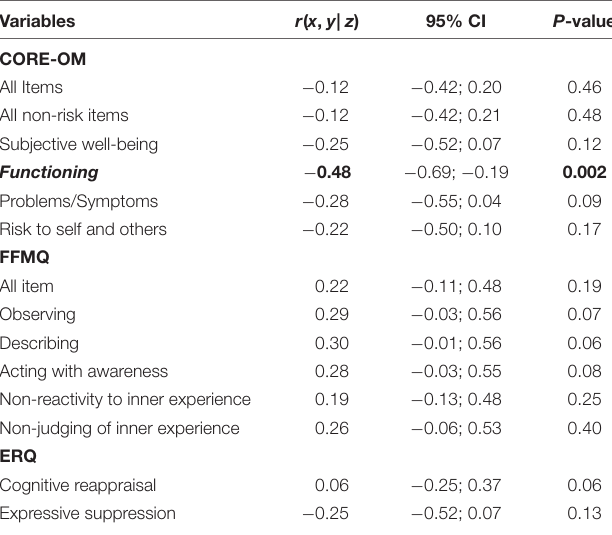
TABLE 4 | Partial correlation r ( x , y | z ) between DSES ( x ) and the indicators under study ( y ) at pre-intervention ( t 0 ) adjusted for sex and age ( z ). Variables r ( x , y | z ) 95% CI P